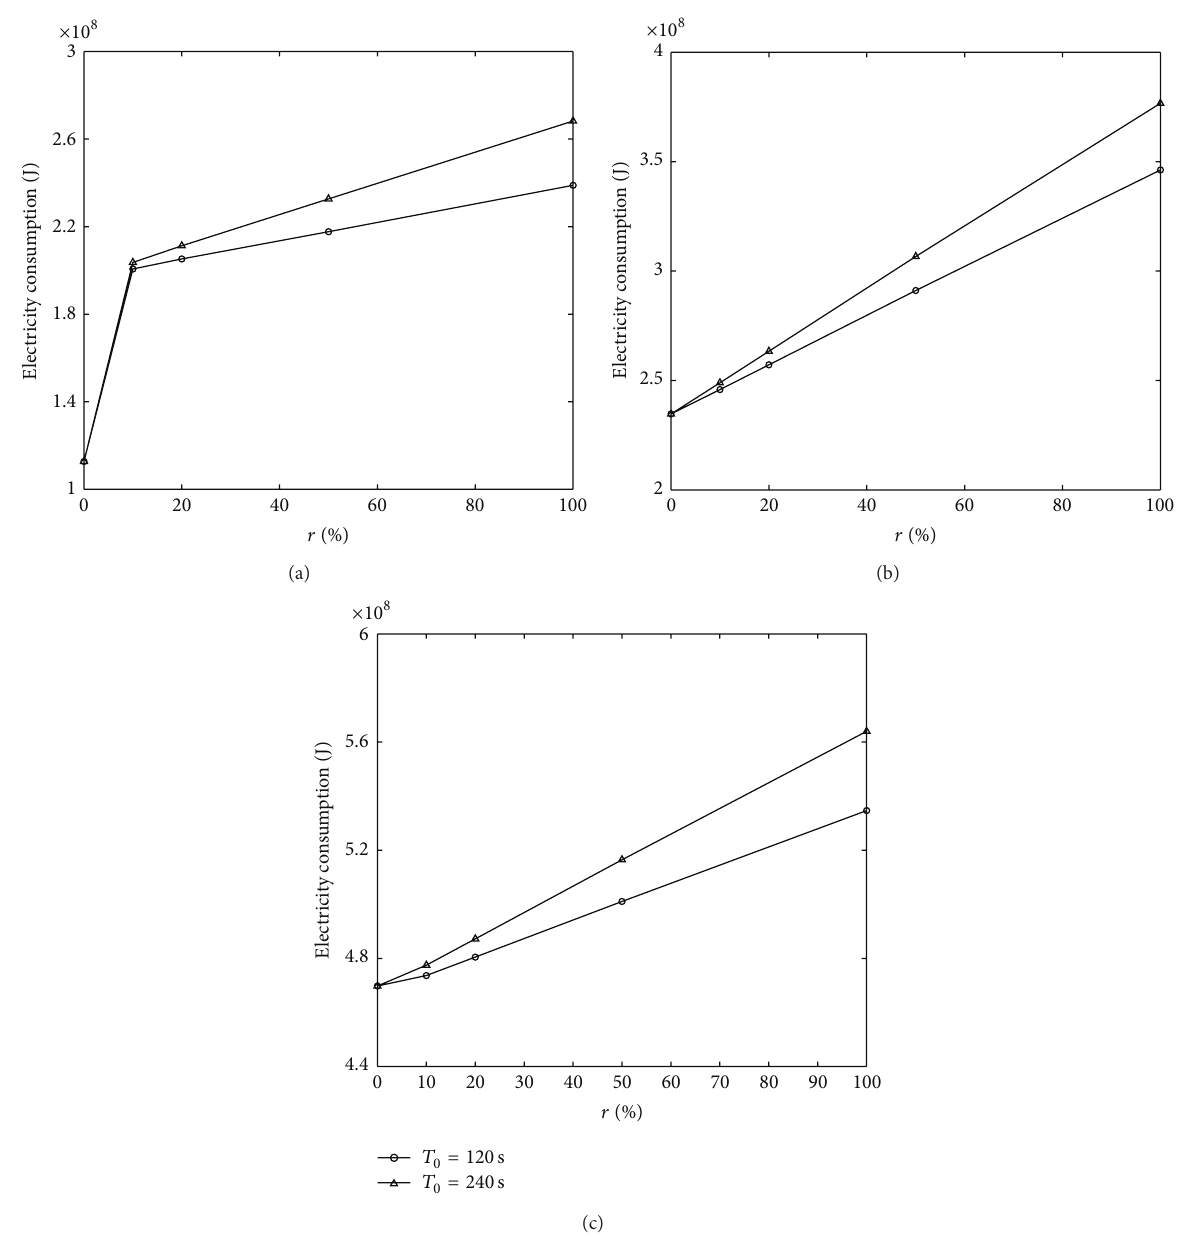
Figure 5: The total electricity consumed by all the vehicles under different conditions, where (a) Δ𝑥 0 = 20 m, (b) Δ𝑥 0 = 40 m, and (c) = 80 Δ𝑥 0